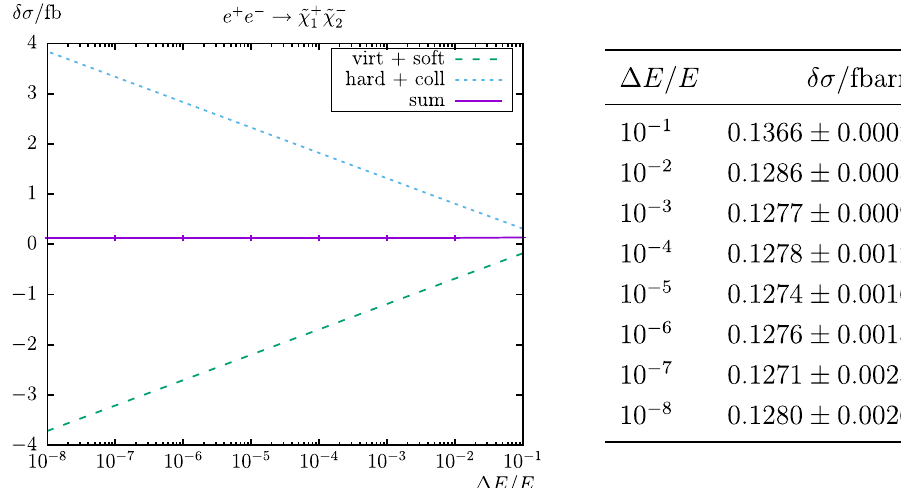
˜ χ ∓ ) for our input parameter scenario 1 2